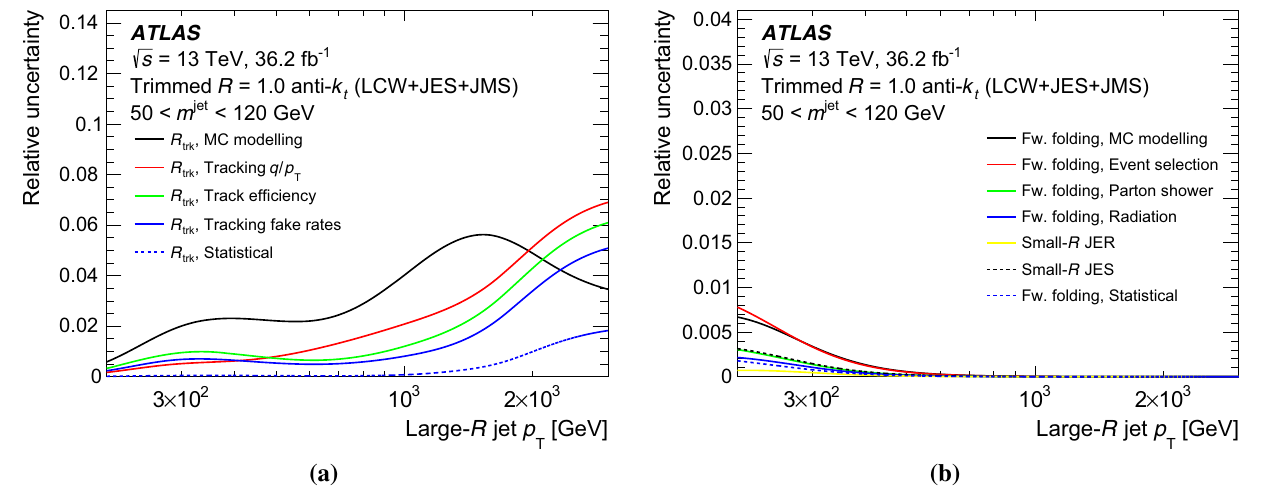
the uncertainty introduced by a given nuisance parameter in combina- tion, incorporating the weight of the method from which it originates. This weight is dominated at high p T by the R trk method. The lines shown are smoothed using a sliding Gaussian kernel